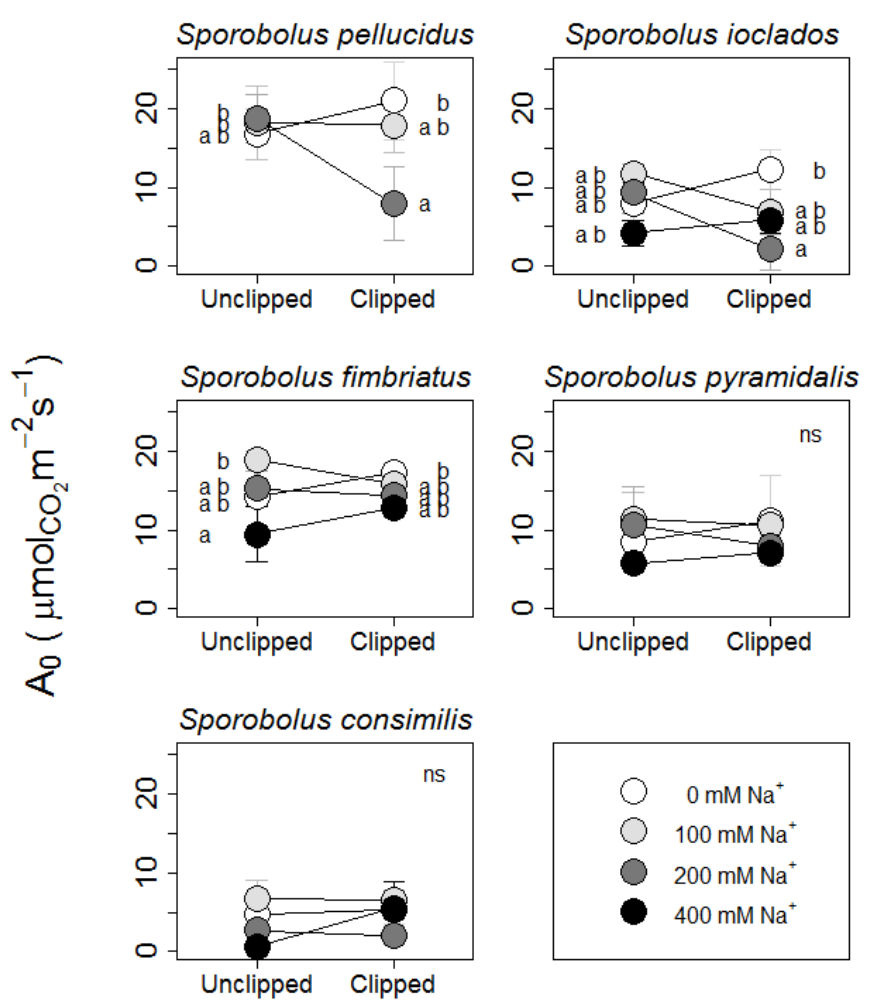
Figure 1. Photosynthesis at 14 days post Na and clipping treatments, represented as individual reaction norms for five Sporobolus species grown in factorial combination of Na (four levels) and clipping (two levels). Points are means ± SE. The point annotations (“a” and “b”) indicate statistically significant differences between groups, across all treatment combinations but within species, given by Tukey’s Honestly Significant Difference on the linear mixed effects model. Species plots are ordered by the maximum leaf height of the represented species. There are no data for S. pellucidus at 400 mM Na due to